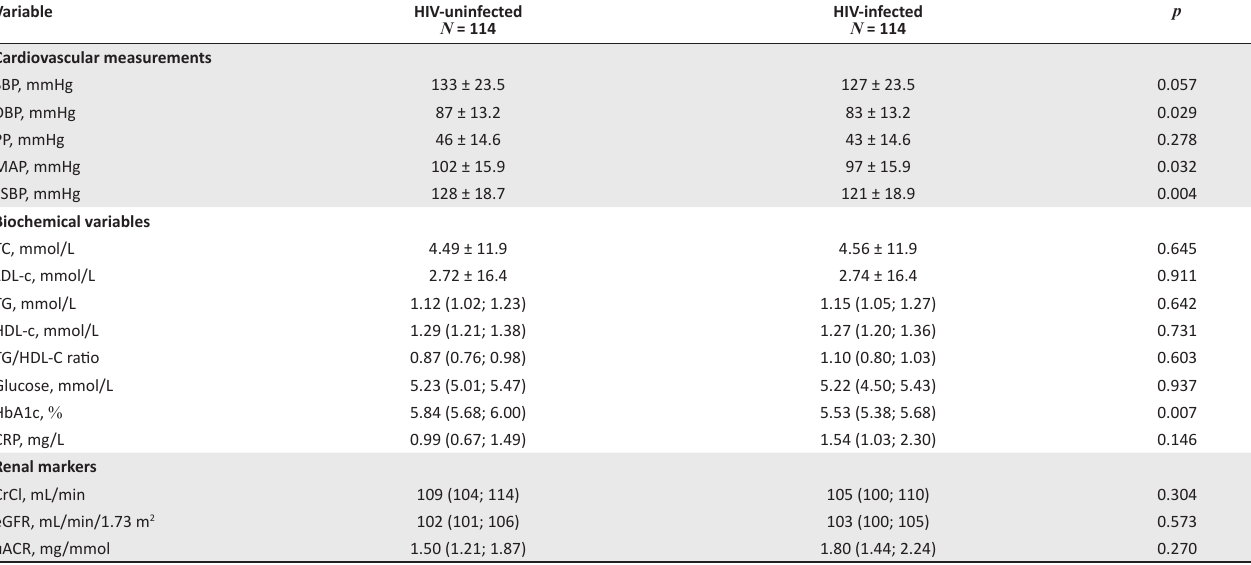
TABLE 1-A1: Characteristics of HIV-uninfected and HIV-infected individuals after adjusting for waist circumference. Variable